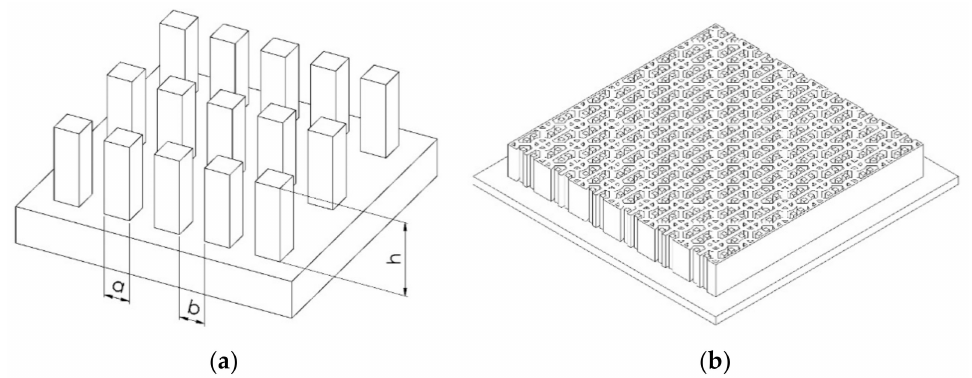
Figure 3. Schematic diagram of the fabricated micro-structures ( a ) square-like pillar (PIL) and ( b ) circular rings with eight stripe supporters (C-RESS) pattern.